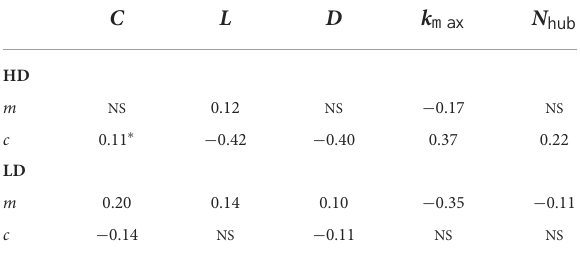
TABLE 1 Partial correlation of graph metrics with branching ratio and